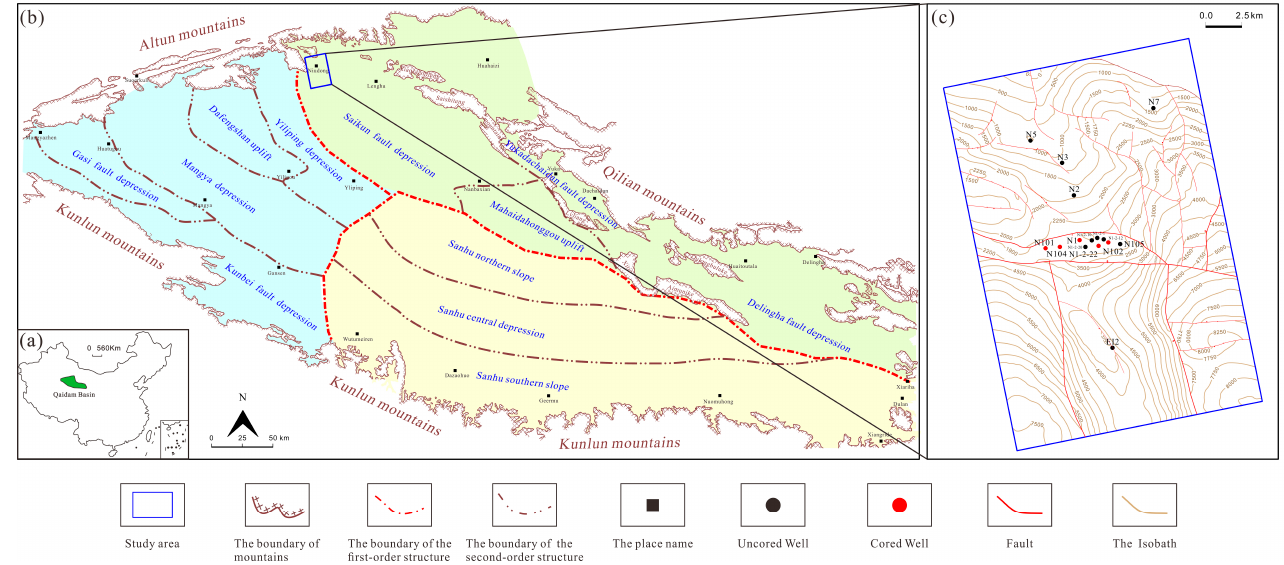
Figure 1. ( a ) Location of Qaidam Basin; ( b ) structure unit division in Qaidam Basin; ( c ) top structure contour map of the strata of the Lower Jurassic reservoir in